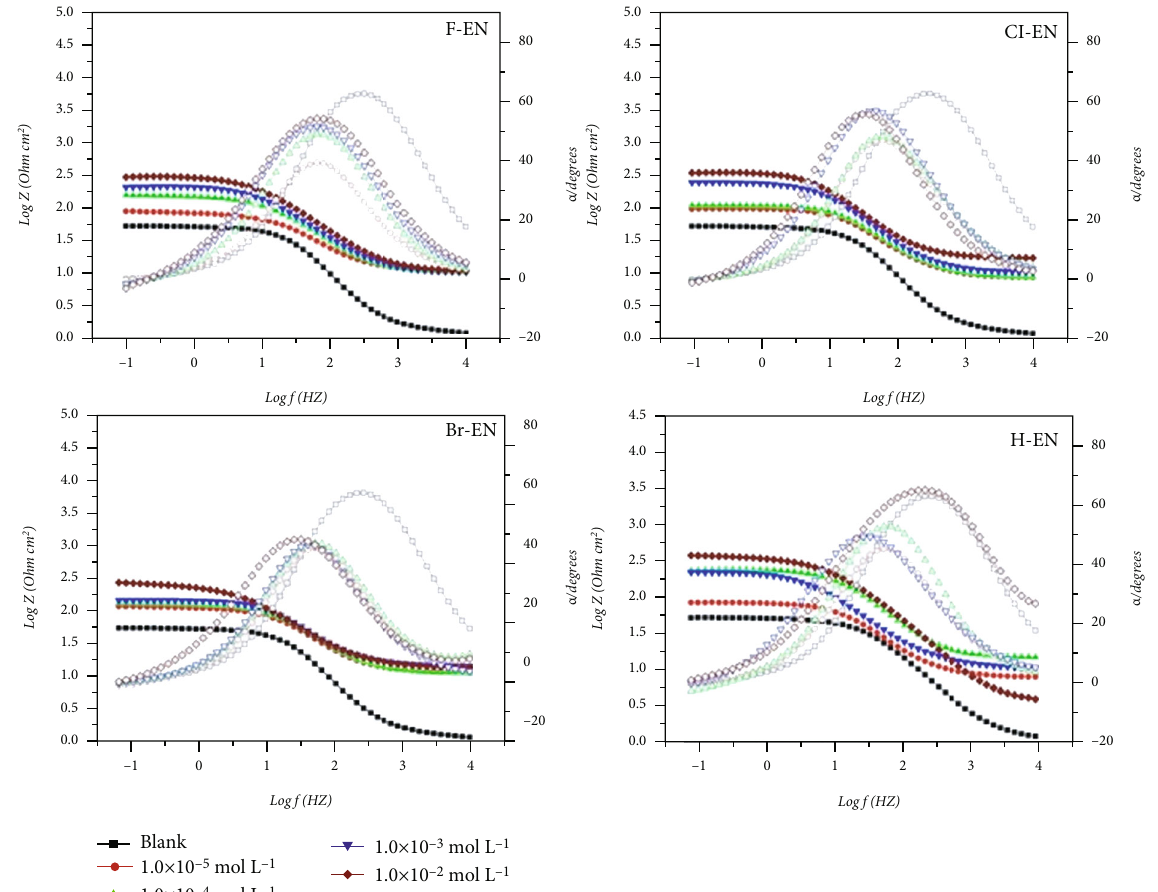
Figure 4: Bode ’ s impedance plots for the carbon steel obtained in 1molL -1 HCl in the presence and absence of the